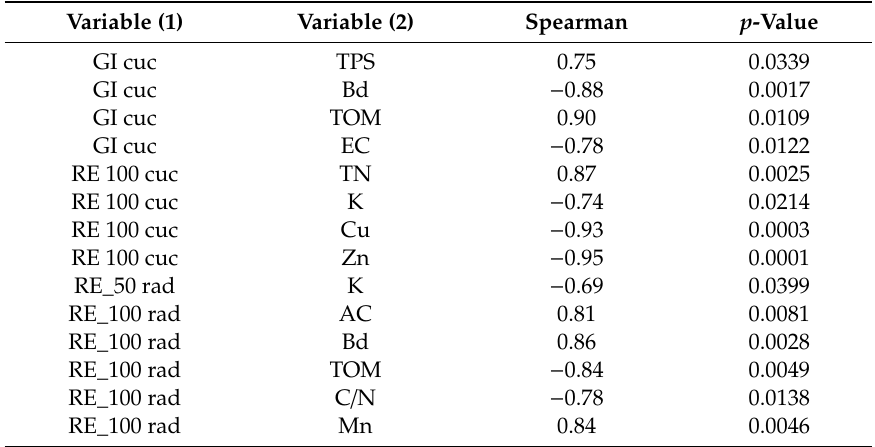
Table 4. Spearman’s correlation analysis between biological variables and physical–chemical parameters of the finished process ( n =